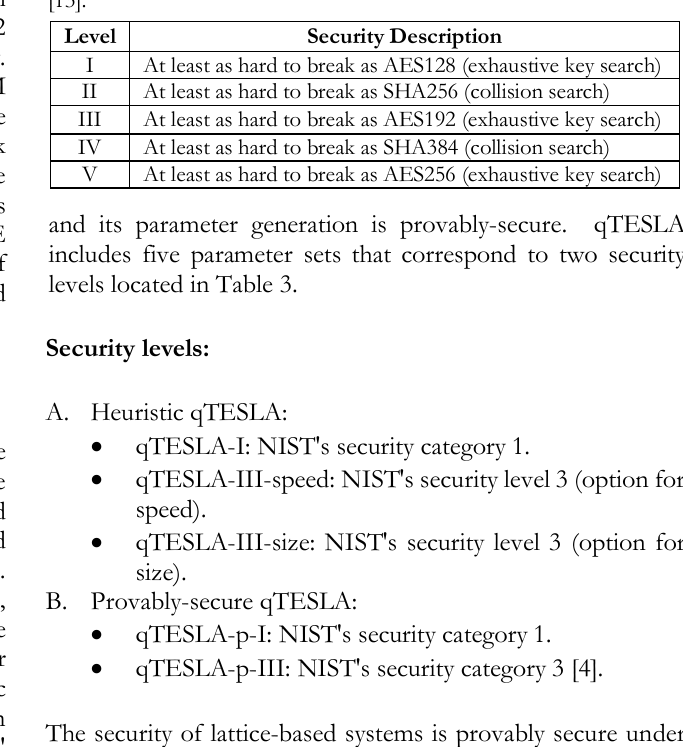
Table 3: Adapted from The NIST Post-Quantum Crypto